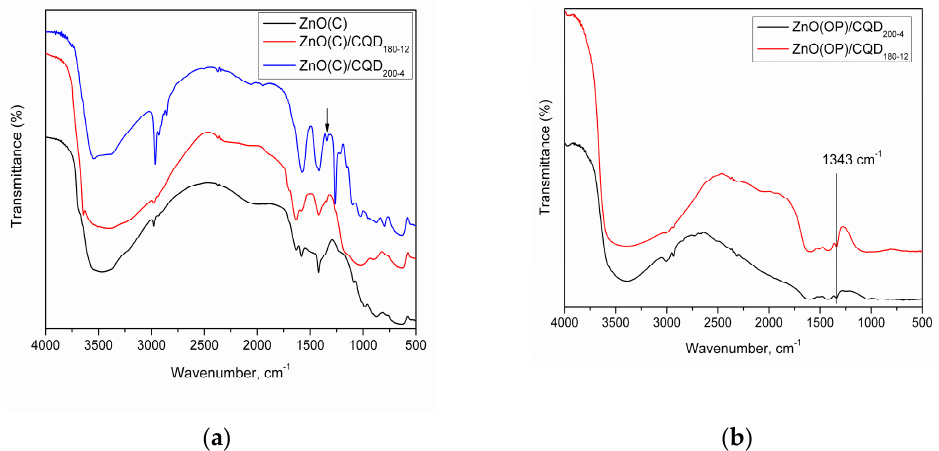
Figure 8. DRIFT spectra of ( a ) ZnO(C)/CQDs and ( b ) ZnO(OP)/CQDs samples. The absorption band at 1260 cm − 1 is ascribed to the C-O-C stretching of the furan ring deformation while the new band at 1338–1345 cm − 1 for ZnO/CQDs to a new Zn-COO − group formed as a result of the CQDs interaction with the ZnO carrier (Figure 9).